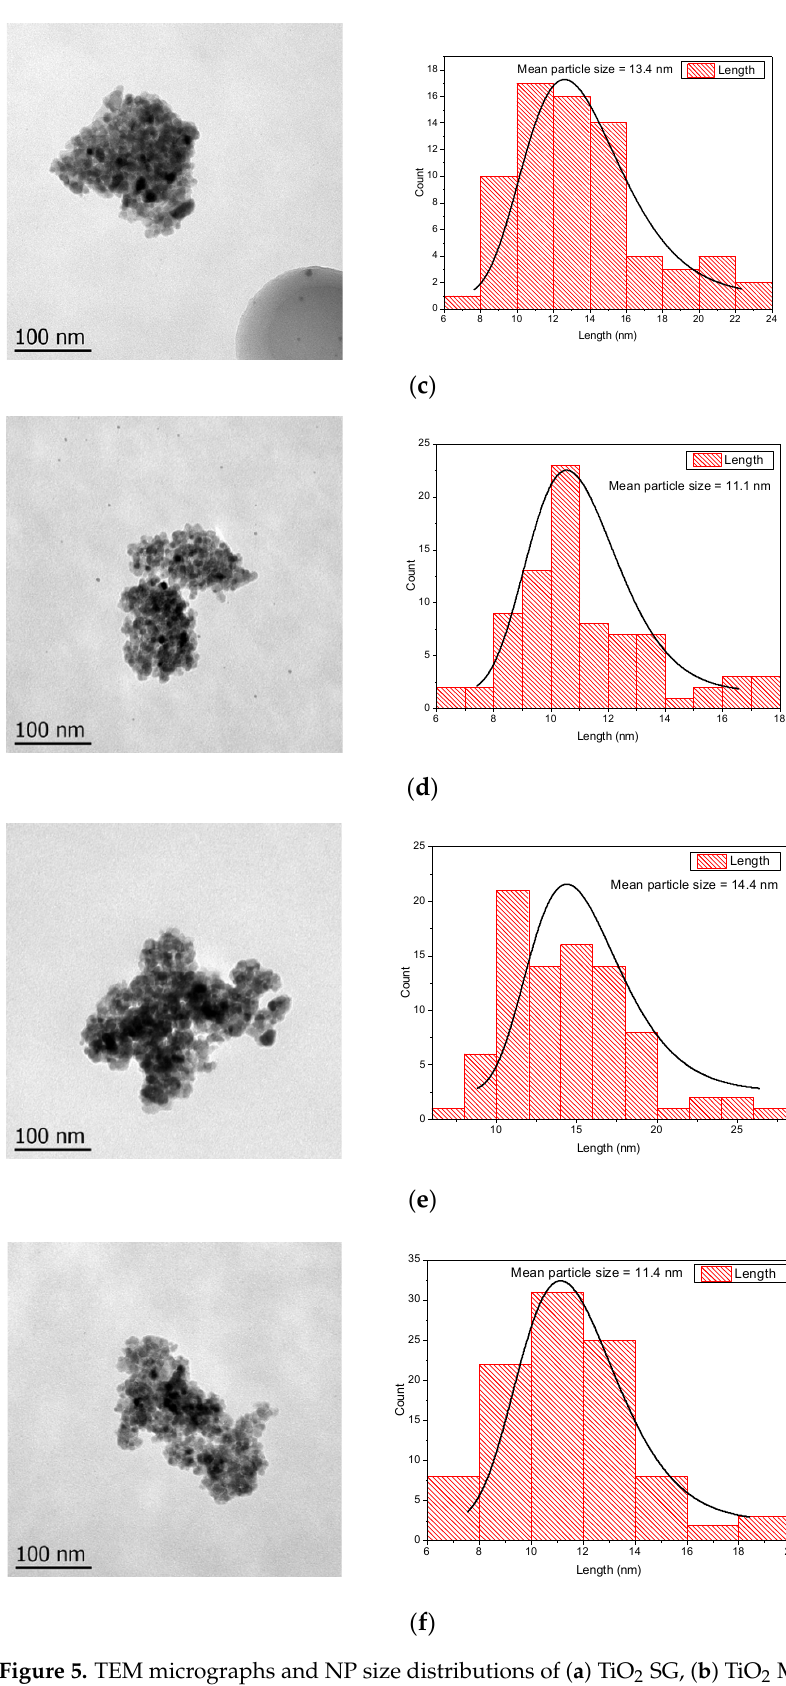
Figure 5. TEM micrographs and NP size distributions of ( a ) TiO 2 SG, ( b ) TiO 2 MW, ( c ) NaBH 4 /Ag- TiO 2 SG, ( d ) NaBH 4 /Ag-TiO 2 MW, ( e ) plant extract/Ag-TiO 2 SG, ( f ) plant extract/Ag-TiO 2 MW.